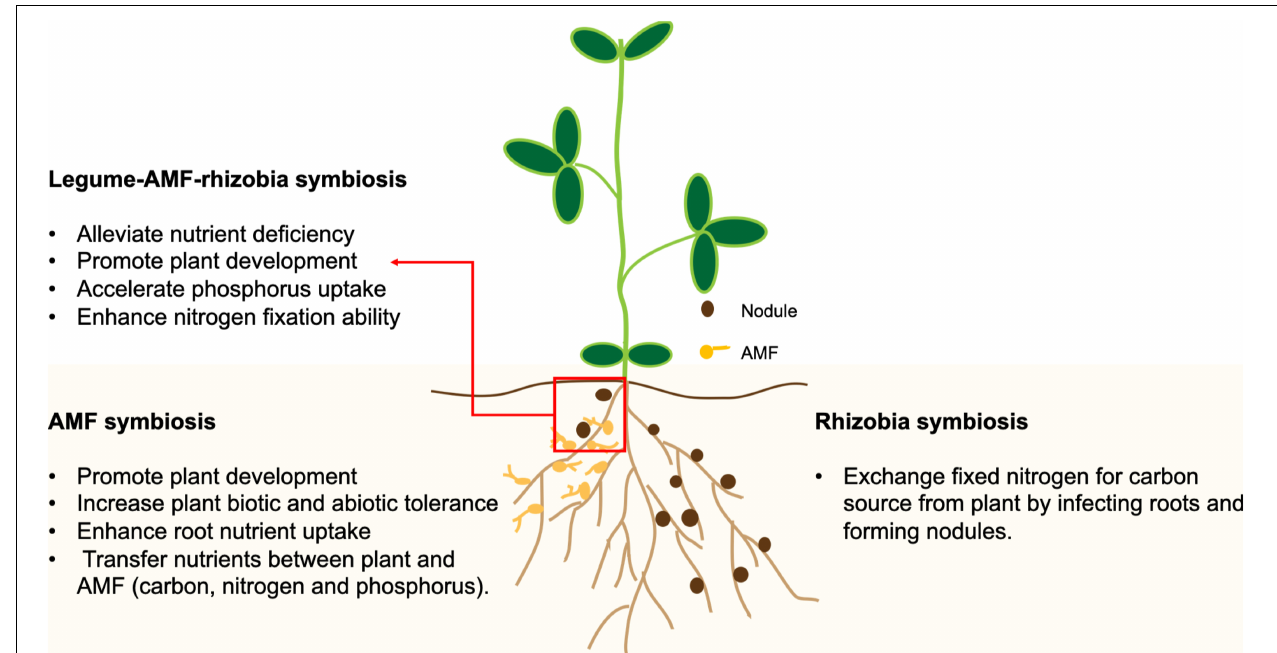
FIGURE 1 | A schematic drawing representing the impacts of symbioses with arbuscular mycorrhizal fungi (AMF) and rhizobia on plant growth and nutrient